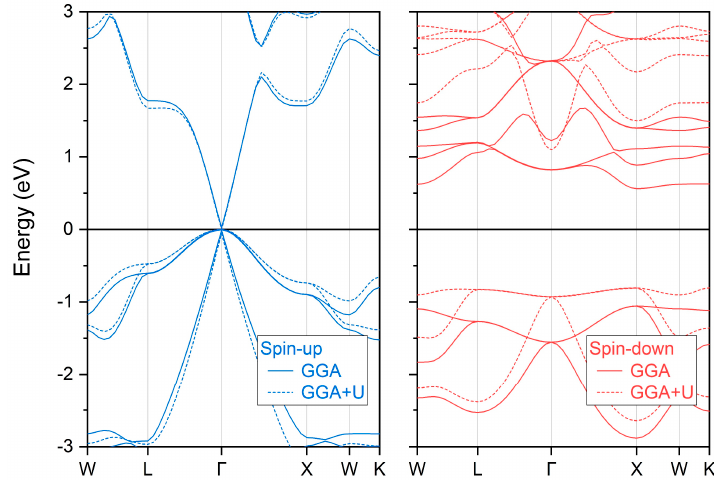
Figure 2. The calculated spin-polarized electronic band structure of half Heusler compound MnPK at the corresponding equilibrium lattice constant. For GGA + U method, 4 eV onside Coulomb energy is applied.